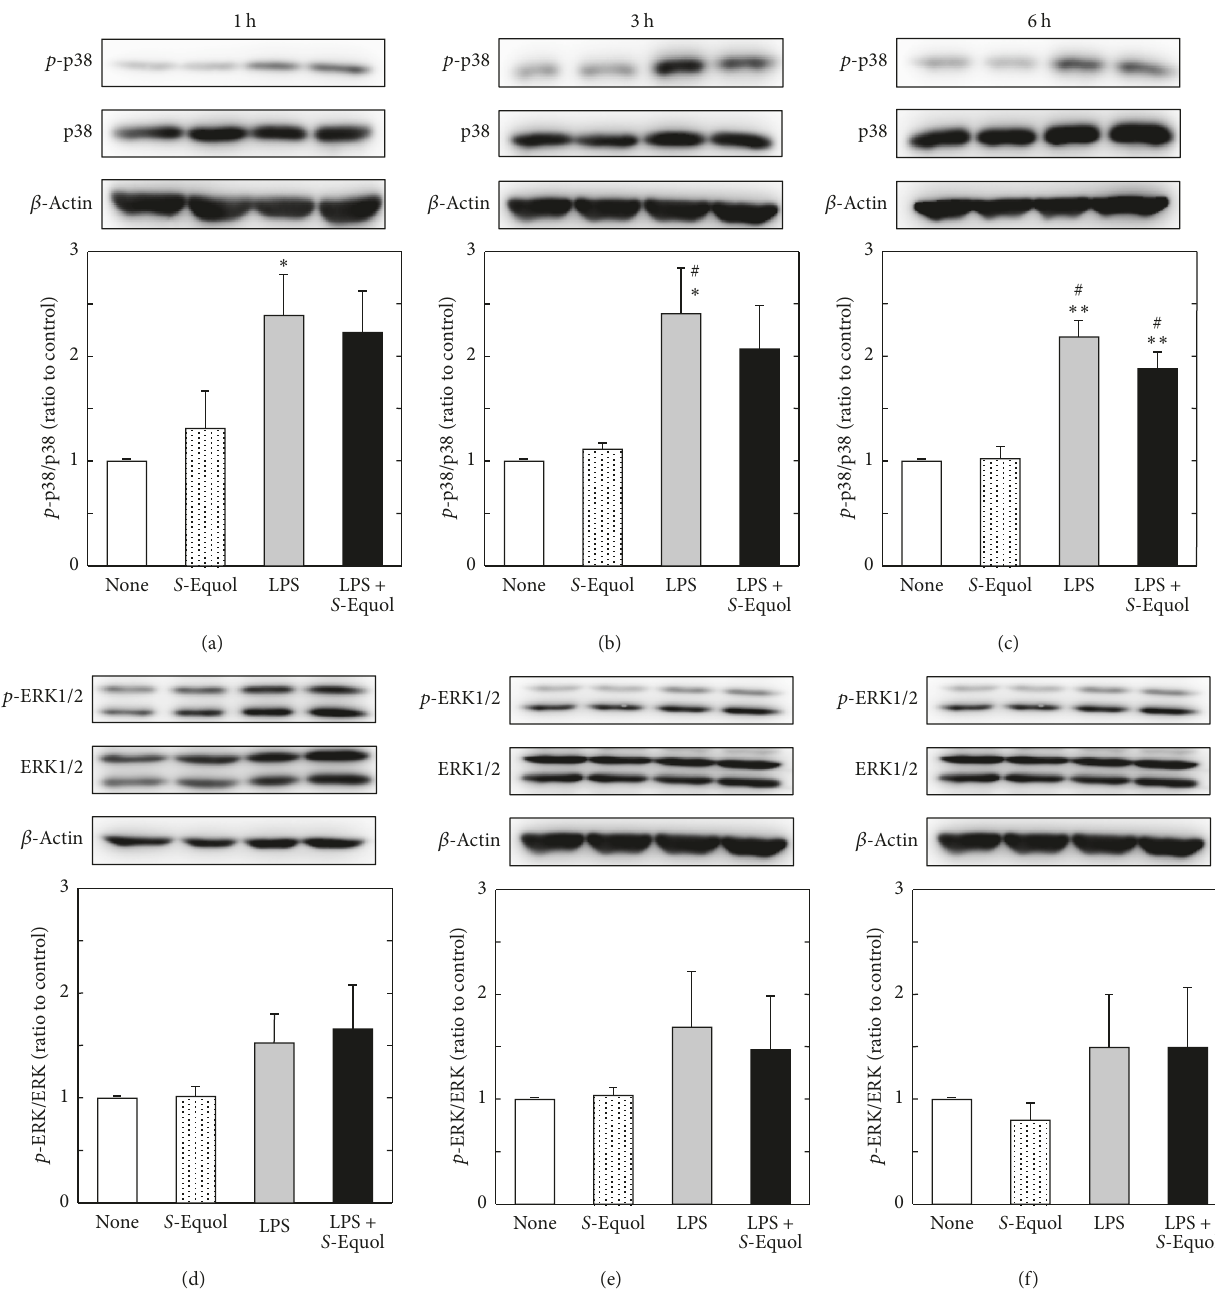
Figure 5: Effect of S -equol on LPS-induced MAPK expression. Cultured astrocytes were treated with LPS (1 𝜇 g/ml) with or without S -equol (50 𝜇 M) for 1, 3, and 6 h, and then the expressions of phosphorylated and total p38-MAPK (a–c) and ERK1/2 (d–f) proteins were detected with western blotting. In case of ERK1/2, total density of two bands was analyzed. Data are the mean ± SEM of 4 samples. ∗ 𝑝 < 0.05 ; ∗∗ 𝑝 < 0.01 significantly different from the nontreated control. # 𝑝 < 0.05 significantly different from S